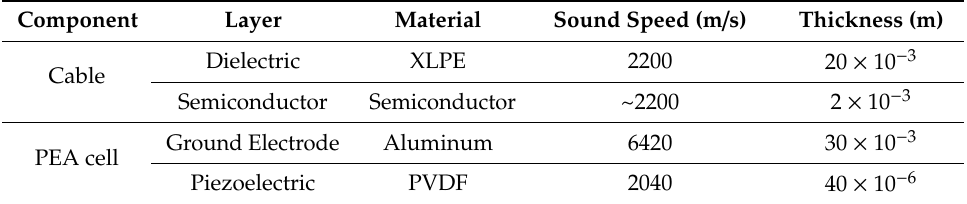
Table 1. Main PEA cell and cable layers features.